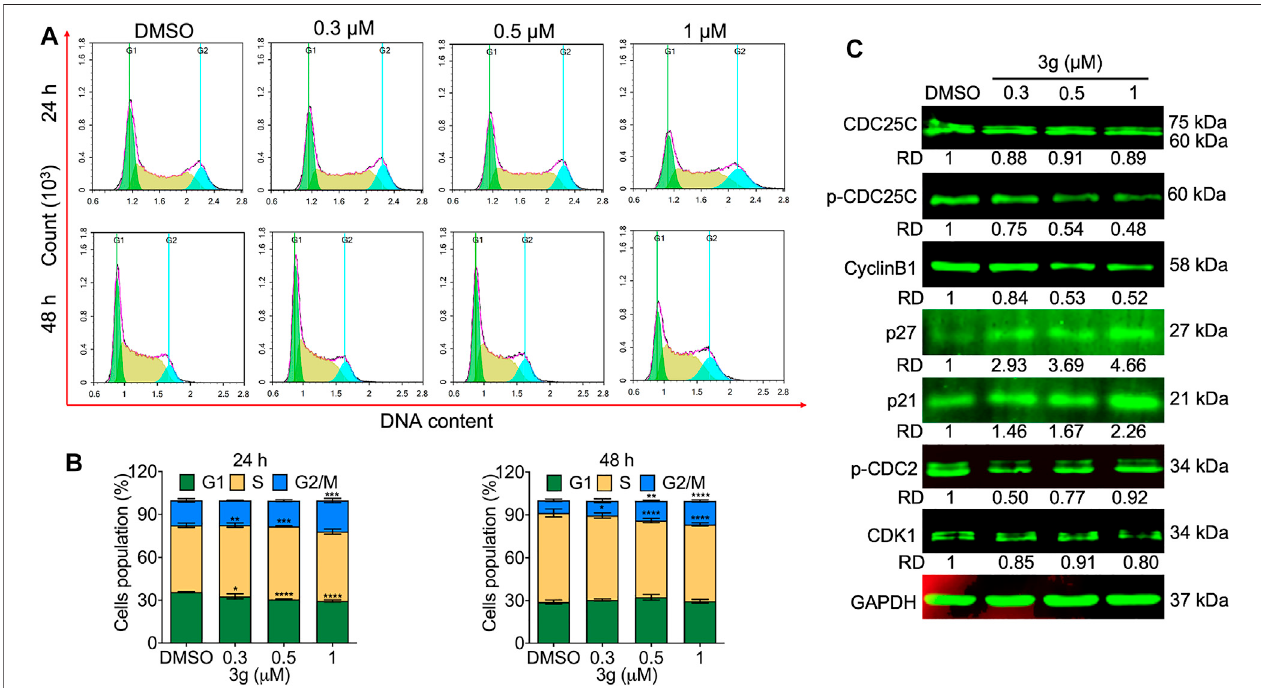
FIGURE 3 | 3g arrests the cell cycle in K562 cells. (A) Cell cycle arrest evaluation by fl ow cytometry after 24 and 48 h of 3g treatment. (B) Densitometry plots depictingthevariationsinthestagesofcellcyclearrest. (C) Proteinexpressionlevelsofindicatedproteinsafter48 hof3gincubation.Dataarerepresentedasmean±SD ( n = 3; * p < 0.05, ** p < 0.01, *** p < 0.001, and **** p < 0.0001 vs.